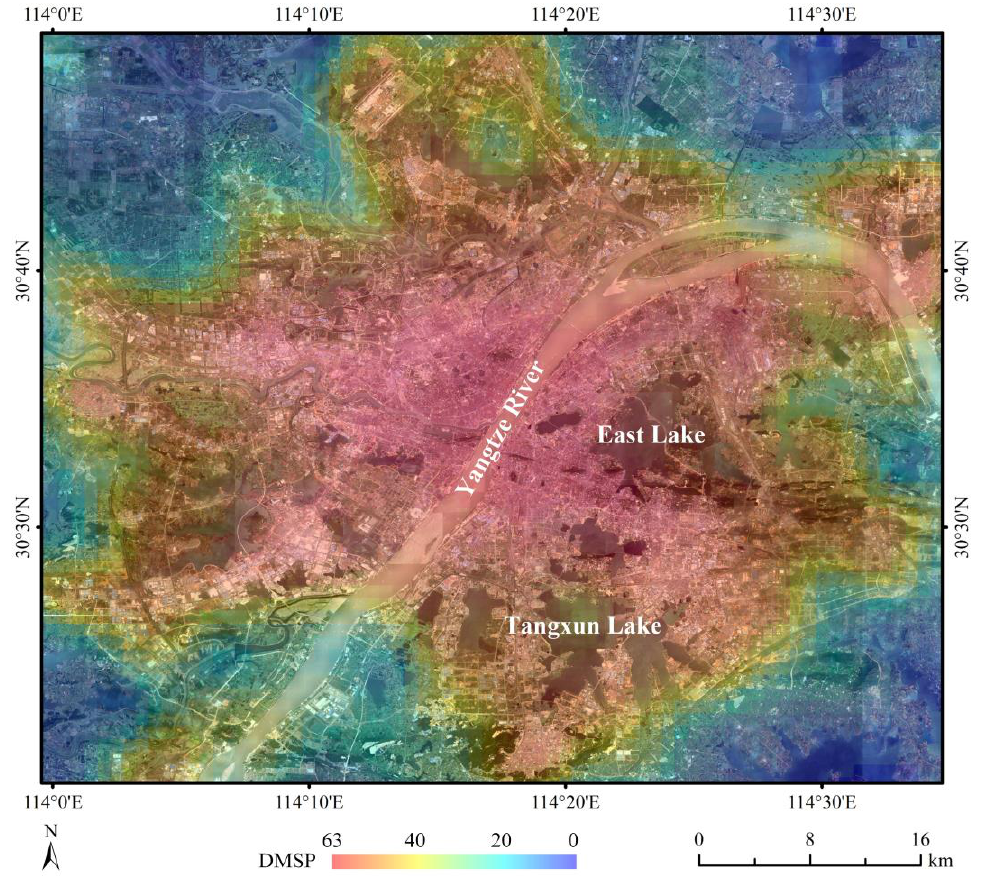
Figure 1. Original Defense Meteorological Satellite Program (DMSP) nighttime light image overlaid on Google Earth image for Wuhan.